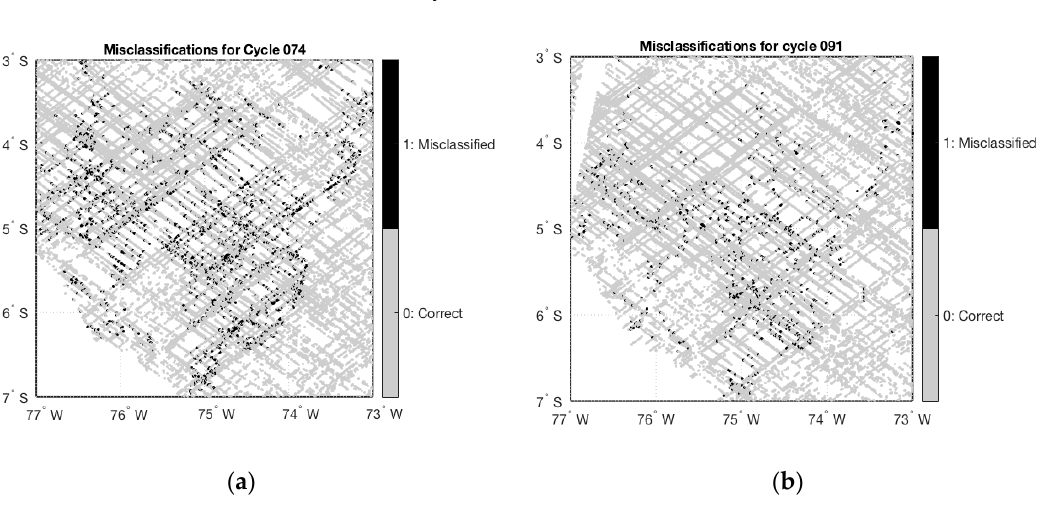
Figure 9. Inundation classification of Pacaya-Samiria using the MDTR algorithm. In the top row, PALSAR-2-based inundation maps used as reference for ( a ) cycle 74 during the end of the high-flood season and ( b ) for cycle 91 during the end of the low-flood season. In the bottom row, GNSS-R inundation classification results for the same seasonal cycles: ( c ) cycle 74 and ( d ) cycle 91. For display purposes only, we are showing the CYGNSS results at approximately 3 km.